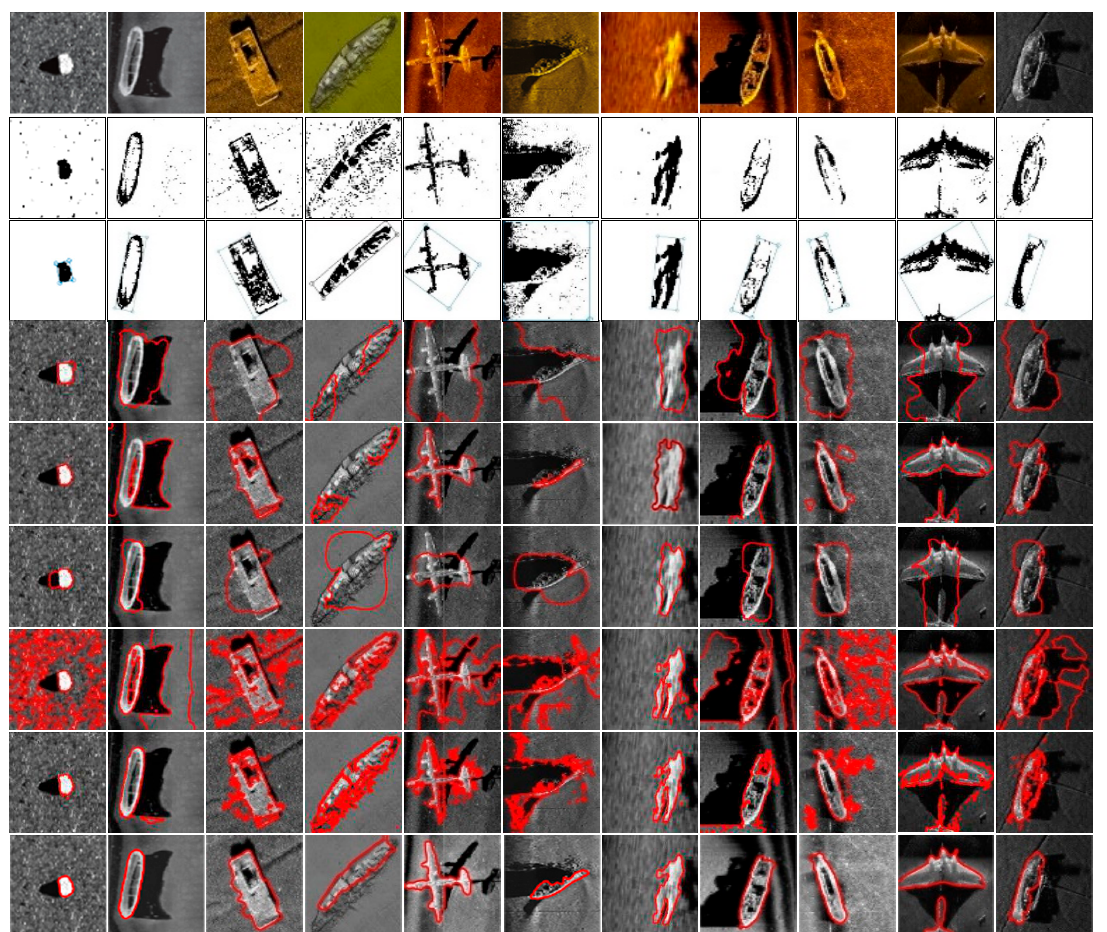
Figure 9. Segmentation of sonar images by the level set method. The first row: Original sonar images (1–11). The second row: Images generated after clustering analysis. The third row: Minimum initial contours generated by the connected domain analysis after removing the straggling points [32]. The fourth to the eighth rows: Comparative tests by using five traditional level set methods (Casells method, Chan Vese method, Lankton method, Li method, and Shi method.) The ninth row: Results of our improved level set method on sonar image segmentation.